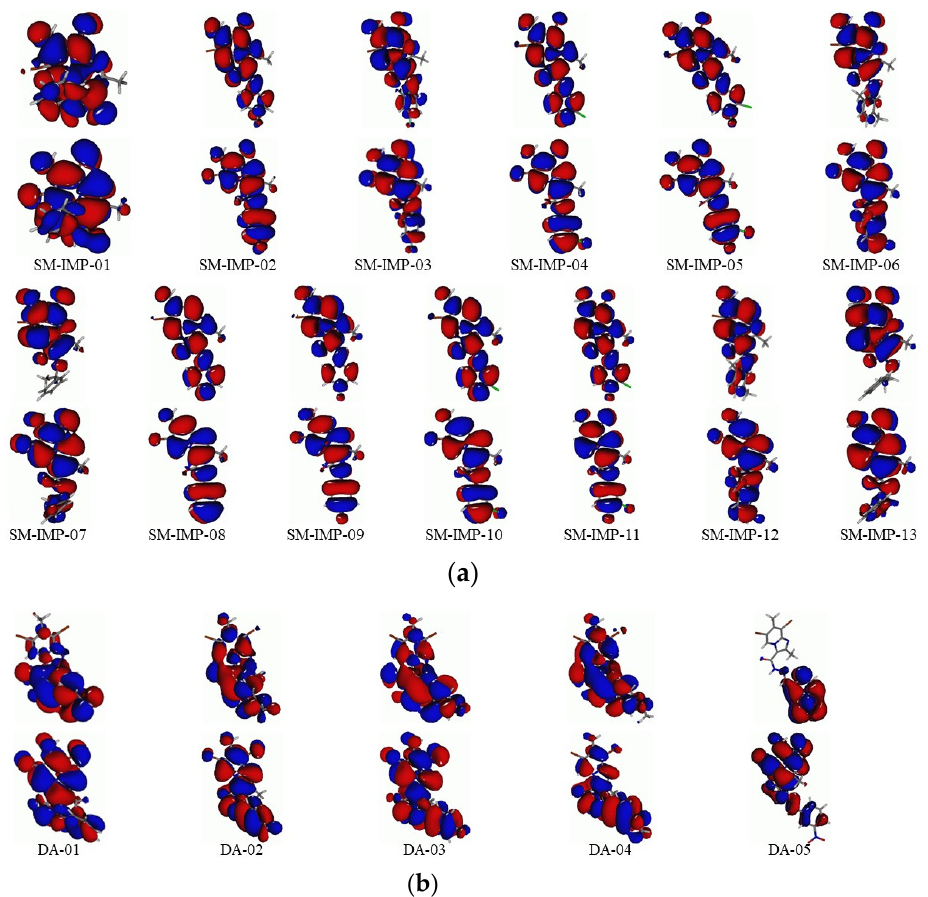
Figure 3. The contour plots of HOMOs and LUMOs for the series SM-IMP-01 to SM-IMP-13 ( a ) and DA-01 to DA-05 ( b ), B3LYP/6-311+G(d,p), implicit water. HOMOs are shown in the bottom row and LUMOs are shown in the top row for each compound.